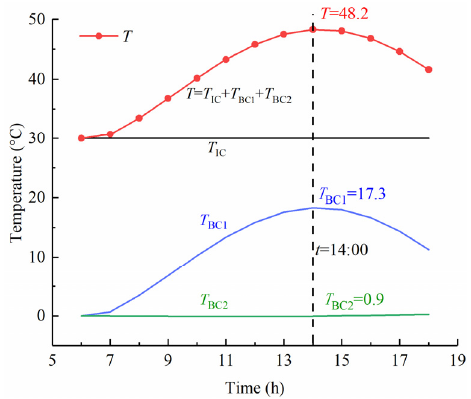
Figure 17. Time history curves of temperature components.